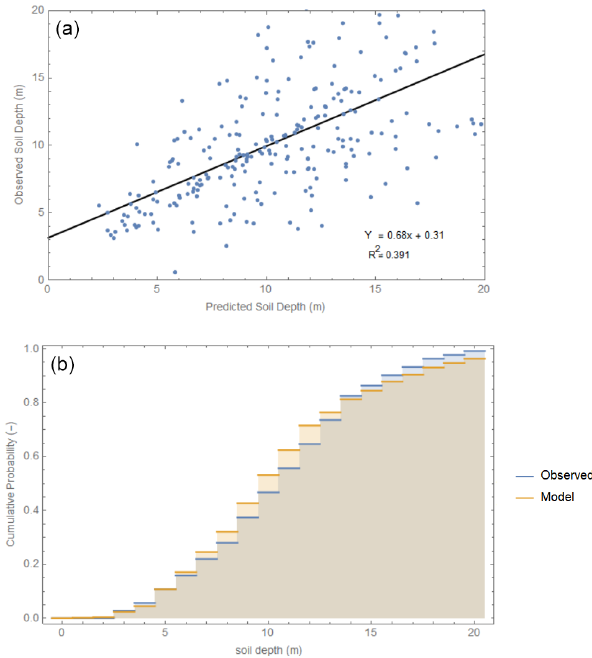
Figure 7. Soil depth simulation results. (a) A comparison of pre- dicted vs. observed values. (b) Probability distribution for observed and simulated soil depth